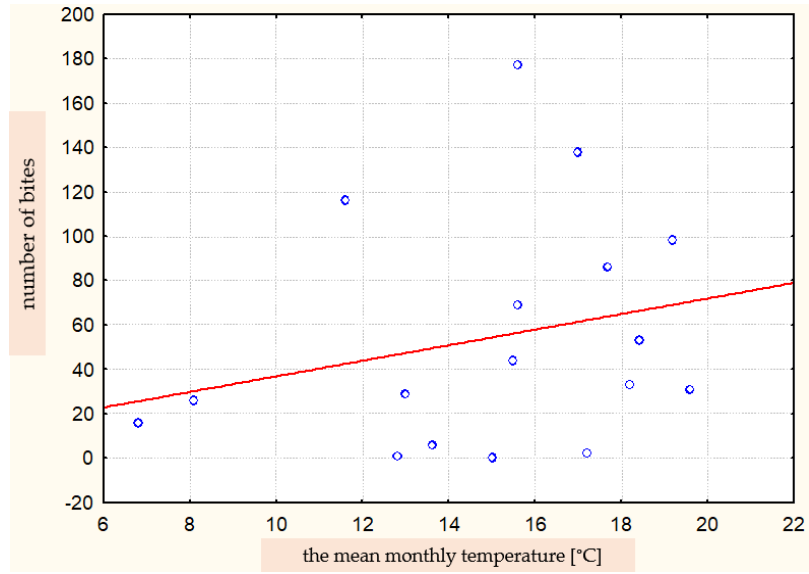
Figure 7. Correlation between the number of bites in a given month and the mean monthly tempera-